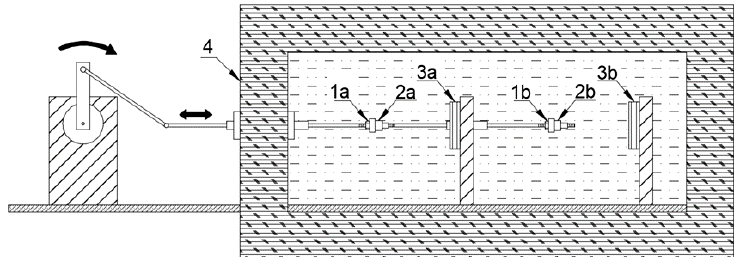
Figure 4. The schematic structure of the experimental setup in the temperature range from − 4 °C to − 20 °C (Elements for setting an oscillation amplitude: 1a/1b—opposite thread 2a/2b—body for fastening of a smaller diameter of the cuff, 3a/3b—body for fastening of a bigger diameter of the cuff, 4—thermo insulated chamber with a refrigerating device).